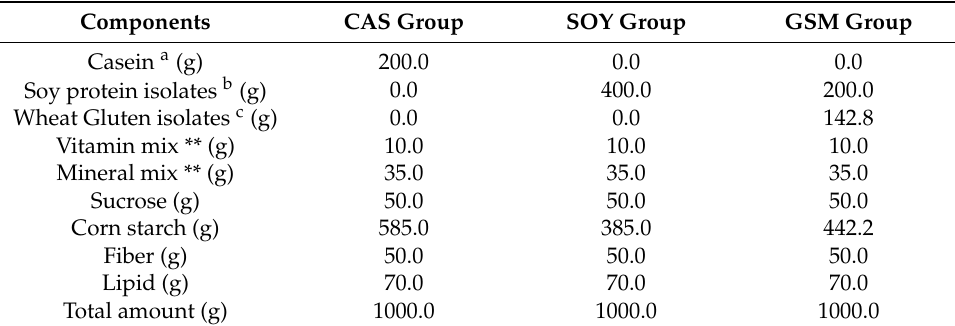
Table 1. Composition of rat chow diet